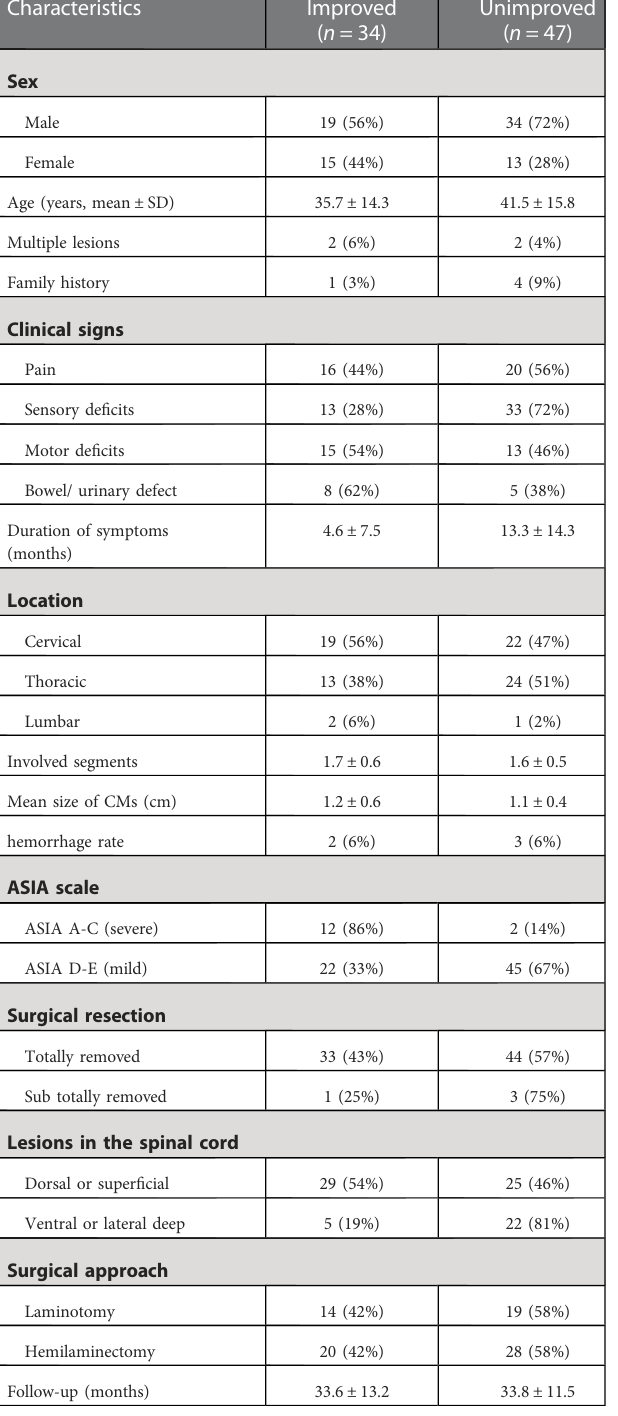
TABLE 1 Characteristics of the improved and unimproved groups.